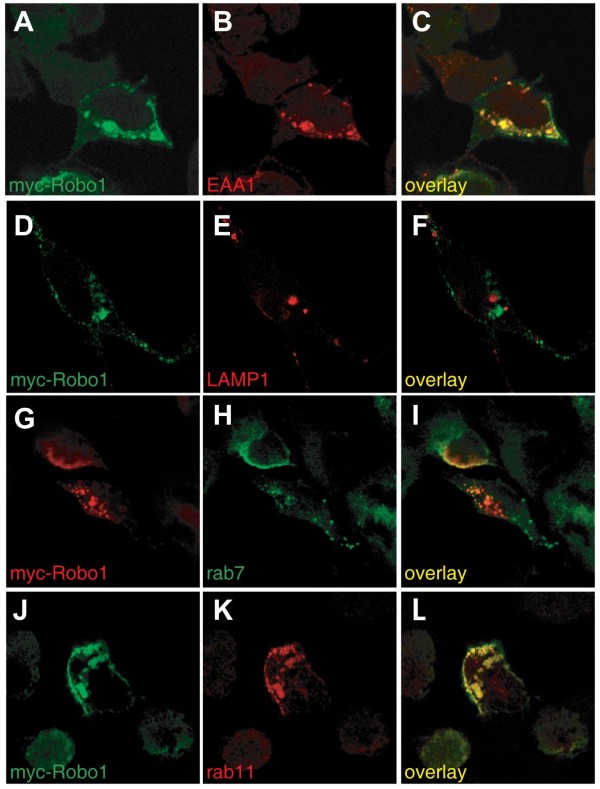
Robo1 localizes to Rab11-positive vesicles. Myc-tagged Robo1 was expressed in HEK293 cells. Antibodies recognizing marker proteins for early endosomes (EAA1) and lysosomes (LAMP1), as well as Rab7 (late endosomes) and Rab11 (labeling recycling endosomes) were used to analyze Robo1 localization in the cell. Robo1 (A) was found to co-localize considerably with EAA1 (B and C). No overlap was seen between Robo1 (D) and LAMP1 (EF). Similarly, Robo1 (G) did not co-localize with Rab7 (HI), indicating that Robo1 was not shuttled to the late endosome/lysosome compartment. Almost complete overlap was found between Robo1 (J) and Rab11 (KL), suggesting that Robo1 was predominantly stored in Rab11-positive vesicles which have been shown to be involved in exocytosis and regulated secretion [58,69]
.